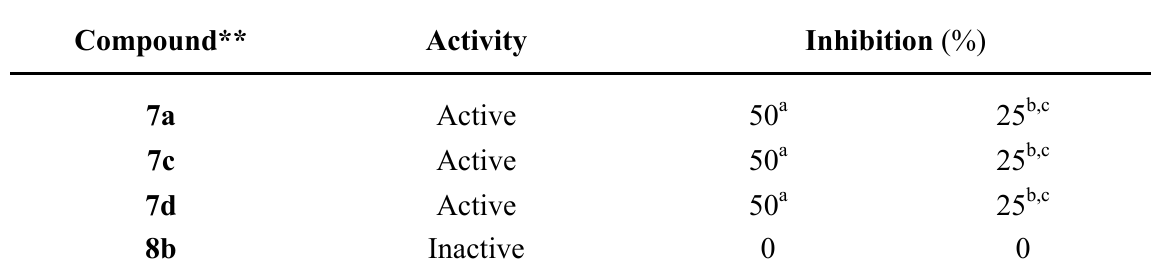
Table 3. Antibacterial activity* of substituted 5-iodouracils 7 and 8